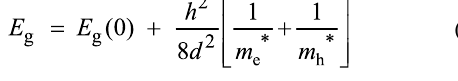
Table 1: Particle size of the PVA-capped CdSe quantum dots, synthesized by the reaction of Cd(AcO) 2 with Na 2 SeSO 3 , in the presence of 9.2% PVA, under the following reaction conditions, as determined from the optical absorption spectra.